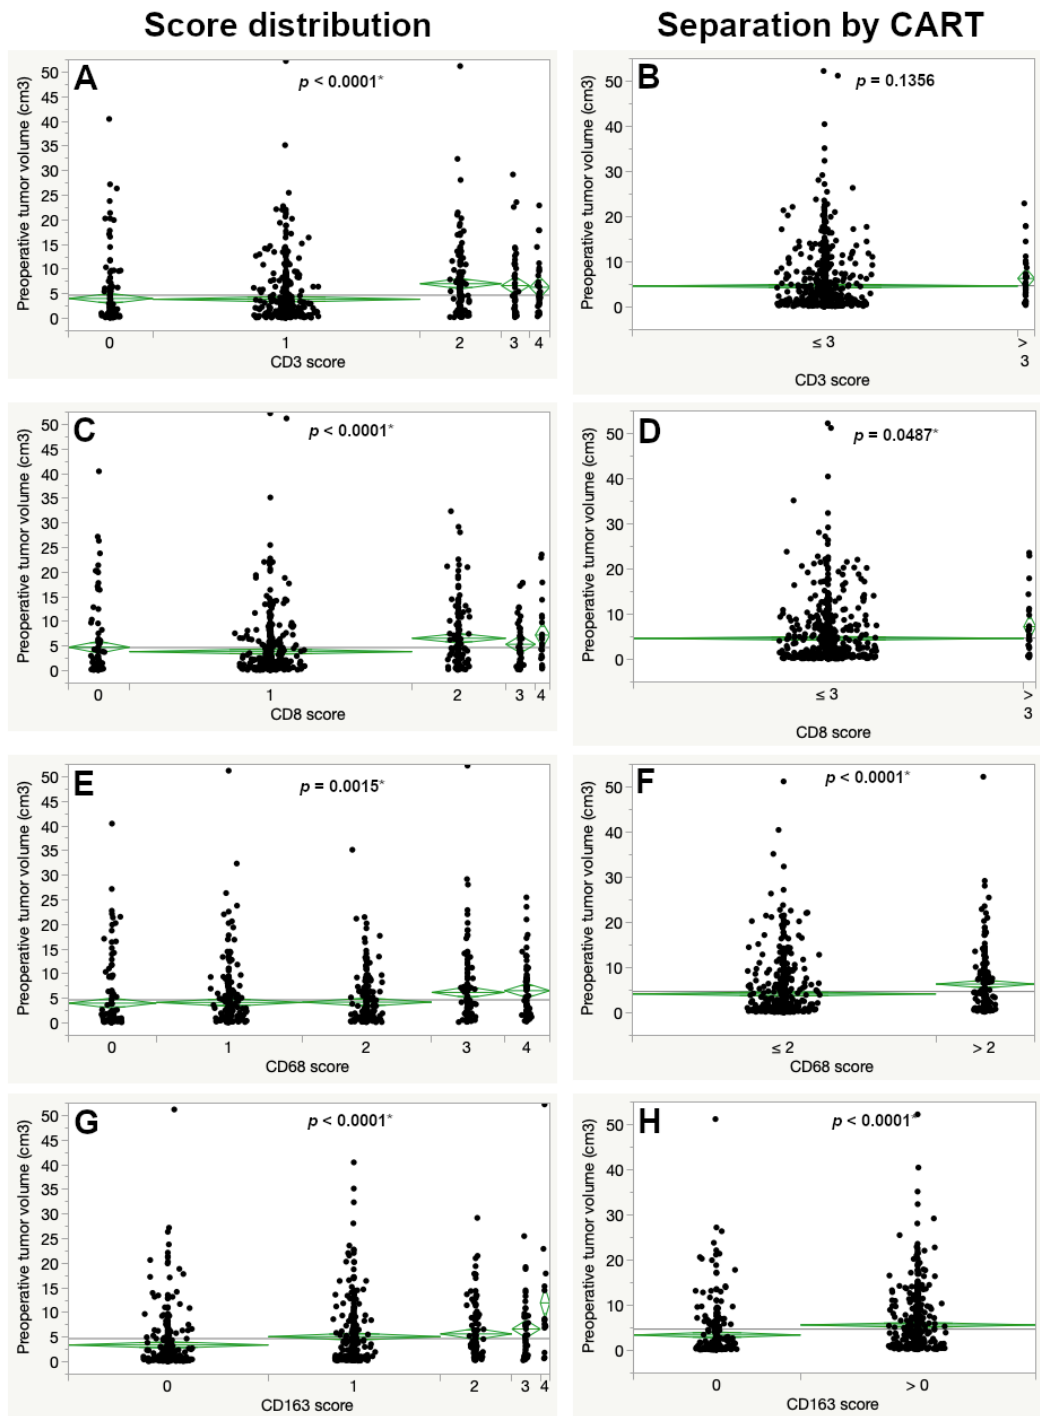
Figure 3. Differences in preoperative tumor volume according to the immunohistochemical ex- pression across the complete immunohistochemistry score (left images) and after determining the CART-specific cut-off (right images) for CD3 ( A , B ), CD8 ( C , D ), CD68 ( E , F ) and CD163 ( G , H ). Sig- nificantly larger preoperative tumor volumes were seen with increased expression of each marker (ANOVA; an asterisk (*) marks statistically significant results).